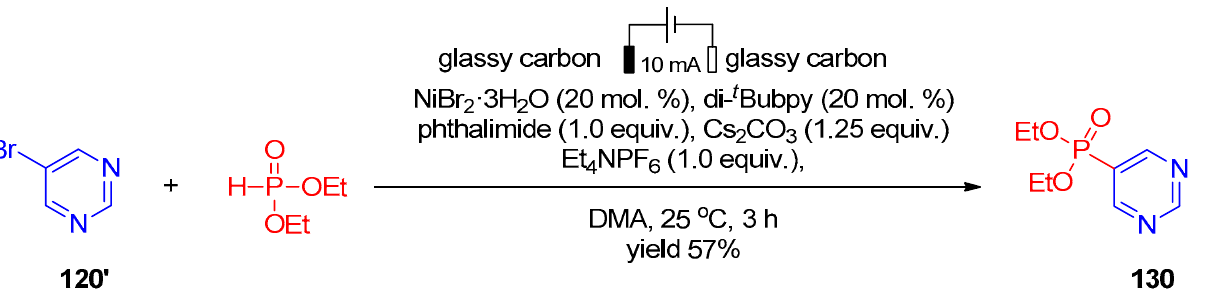
Scheme 33. NiBr 2 -catalyzed electrochemical synthesis of